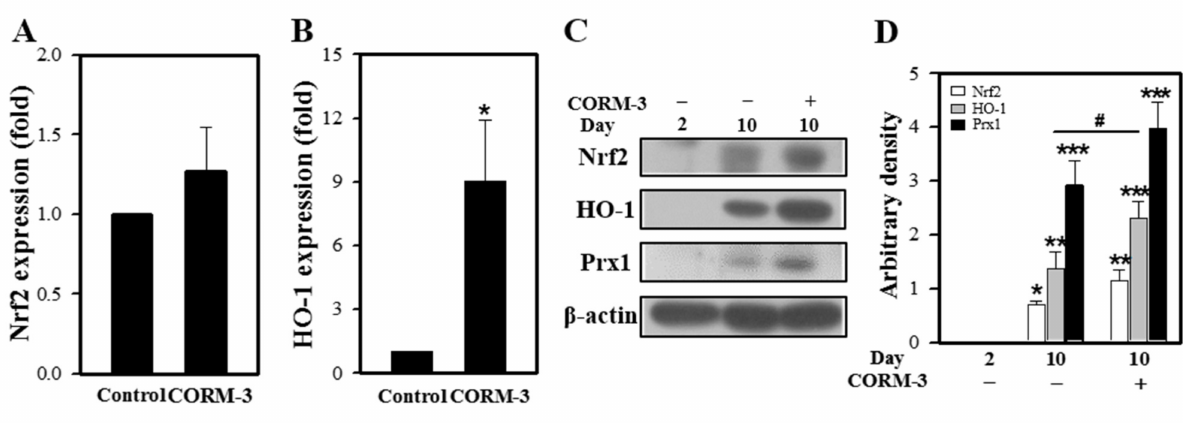
Figure 4. CORM-3 increases Nrf2 and HO-1 expression. Murine BMCs were treated with 100 µ M CORM-3 on day 5 and incubated for 5 days to induce macrophage differentiation. ( A , B ) Gene expression of Nrf2 and HO-1 was measured using qRT-PCR (n = 3). ( C ) The protein levels of Nrf2 (n = 3), HO-1 (n = 5), and Prx1 (n = 4) in differentiated macrophages were determined by immunoblotting and ( D ) the relative densities were calculated as the ratio to β -actin. Results are presented as mean ± SD; * p < 0.05, ** p < 0.01, and *** p < 0.001 compared to control, and # p < 0.05 between groups compared with Student’s t -test for ( A , B ) or one-way ANOVA for ( D